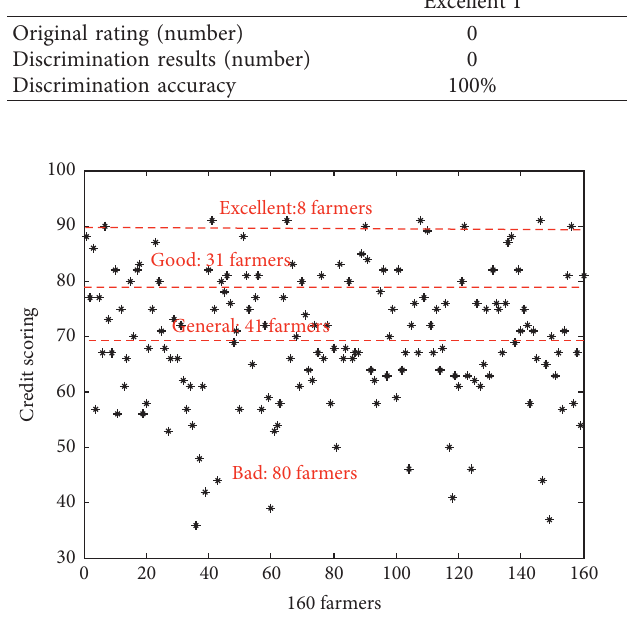
Figure 4: Scatter diagram of credit scoring of 160